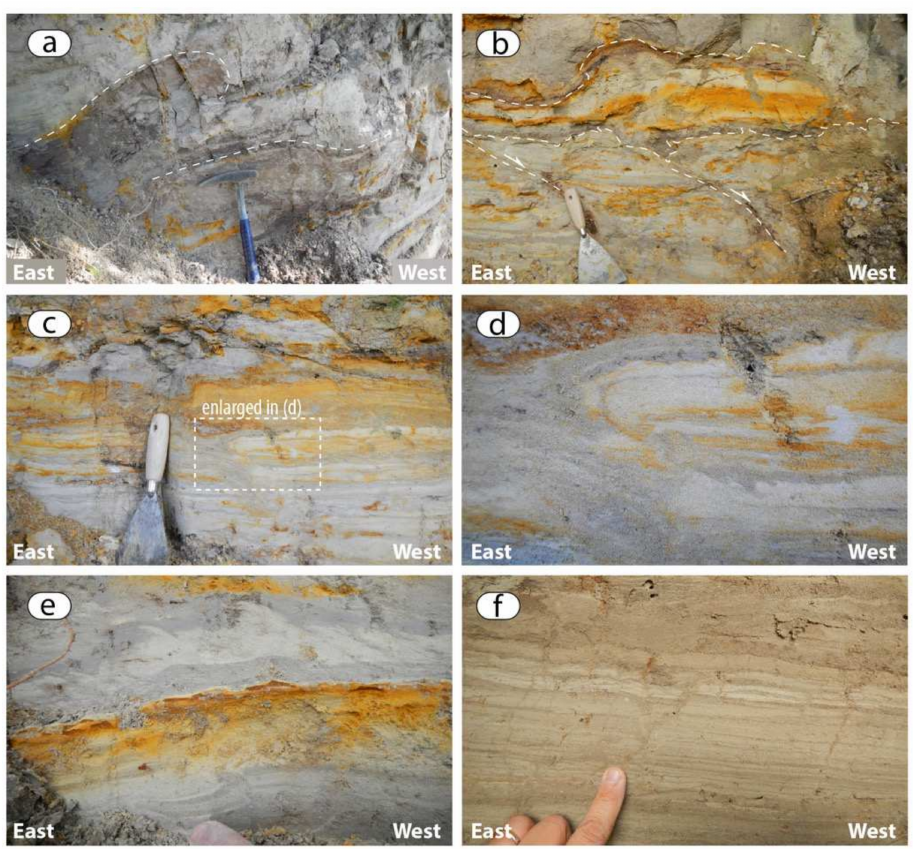
Figure 14. Soft-sediment deformation structures in lacustrine sandy silt (Unit 5b); ( a ) detached highly-non cylindrical fold; ( b ) shear bands and related deformed laminations; ( c , d ) slump sheets; ( e ) slump sheets and deformed laminations; ( f ) clastic